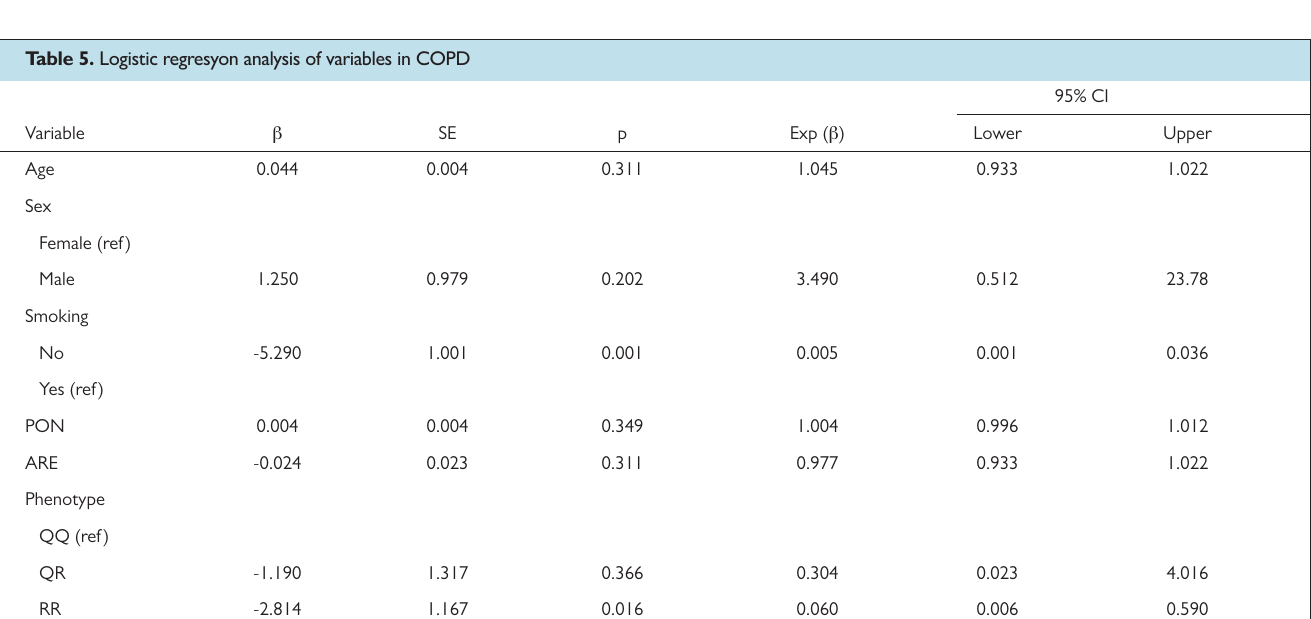
Table 5. Logistic regresyon analysis of variables in